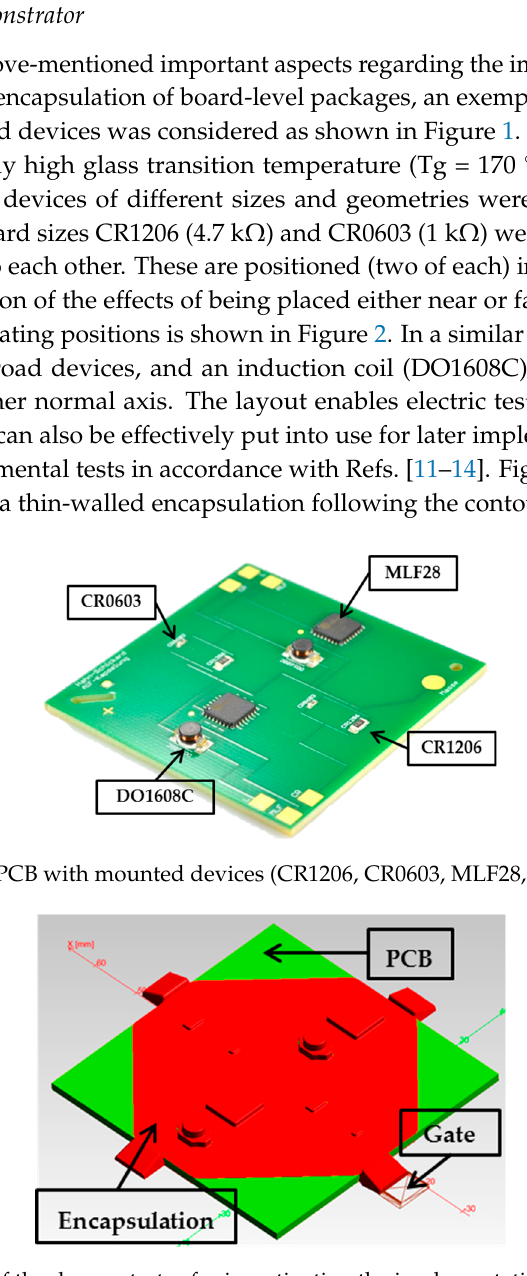
Figure 2. CAD model of the demonstrator for investigating the implementation of thermoset injection molding for thin-walled encapsulations of board-level packages.